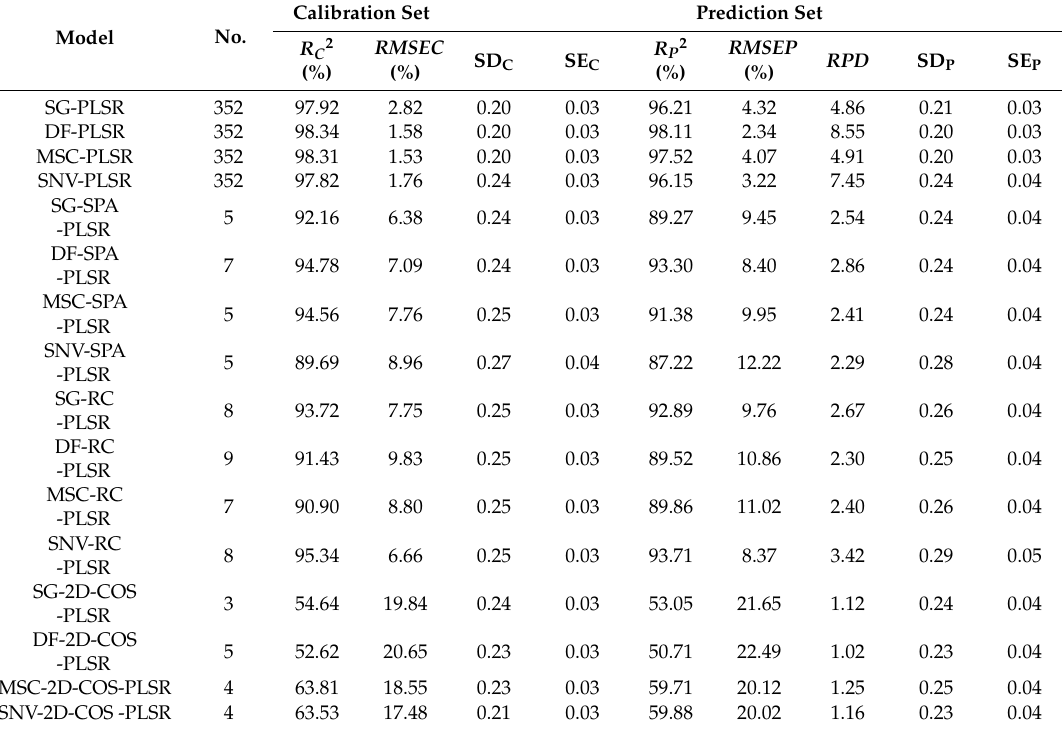
Table 7. Evaluating parameters of PLSR model of the tail